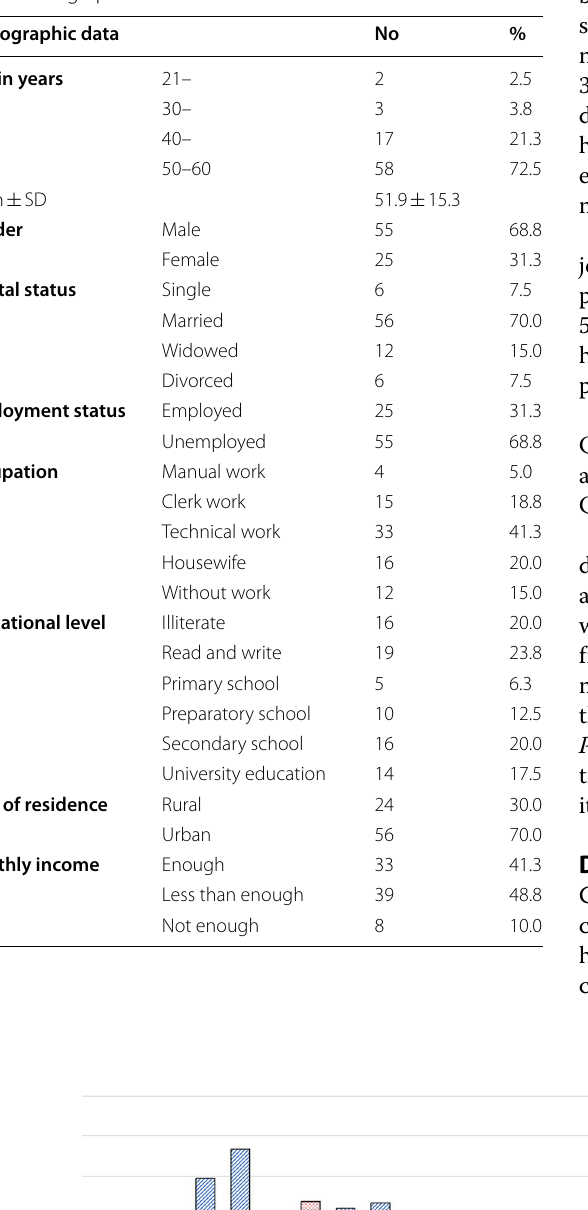
Table 1 Distribution of the study subjects according to their socio-demographic characteristics